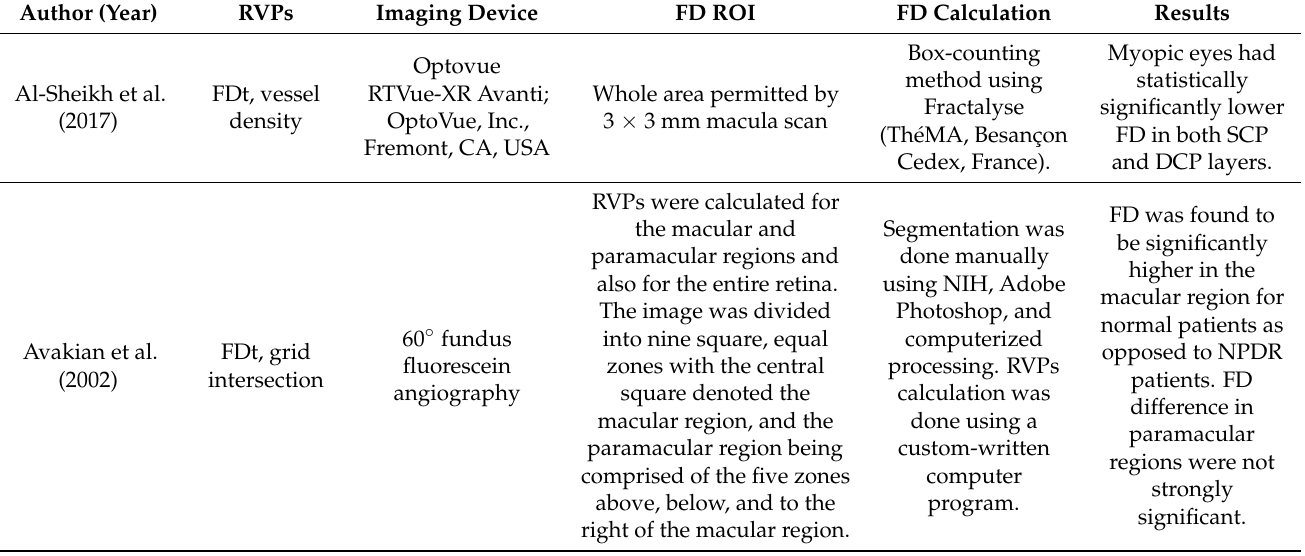
Table 3. Outcomes of fractal analysis for retinal